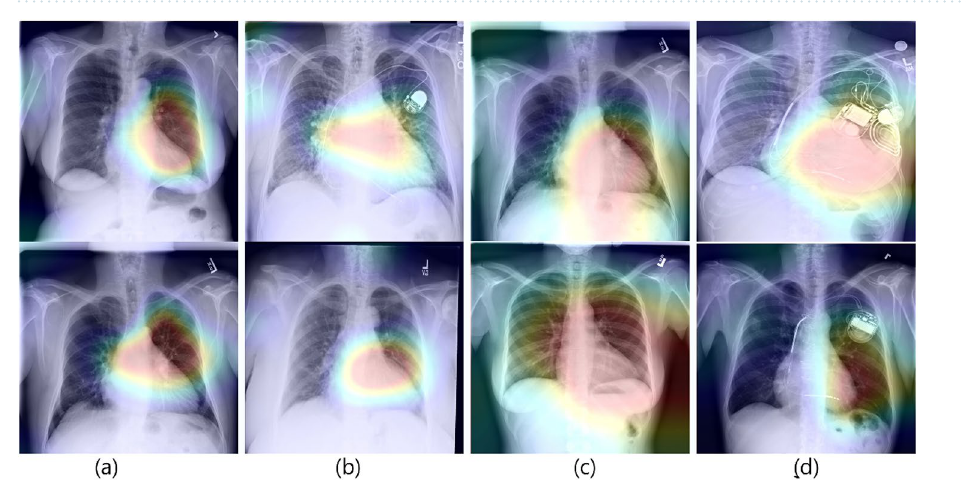
Figure 8. A visual illustration of superimposing the Attention Map on the corresponding cardiomegaly chest x-ray images with intensity factor 0.2. Outputs of CXA_Dense121 ( a ), CXA_Dense201 ( b ), CXA_IncepRes2 ( c ) and CXA_Res50 ( d ) are sequentially from left to